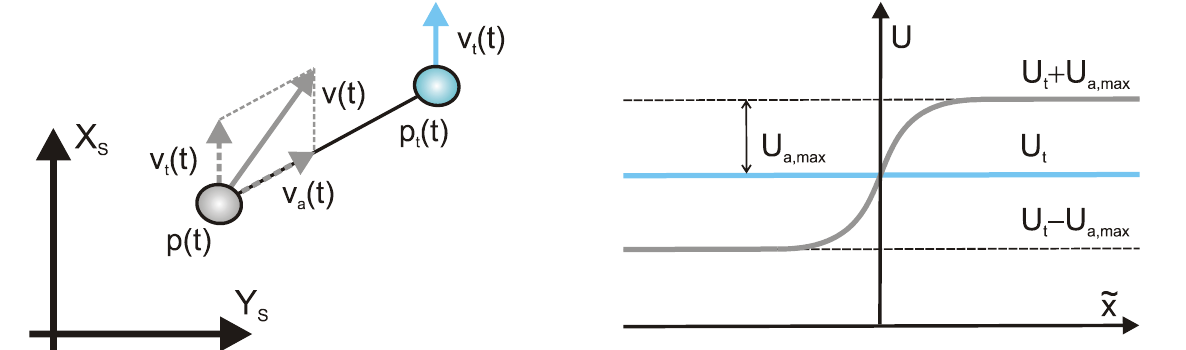
Figure 4: The direct velocity assignment associated with CB guidance.